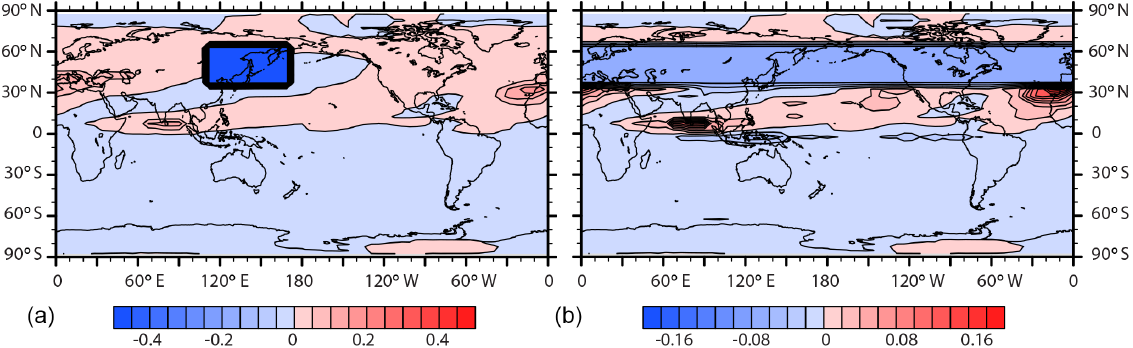
Figure 2. Two examples of the GWD enhancement horizontal distribution imposed between approx. 20 and 30km of log-pressure height. Left panel: box distribution (Box0.1 simulation). Right panel: ring distribution (Zon0.1 simulation). Colours indicate GW-induced zonal acceleration [ms − 1 day − 1